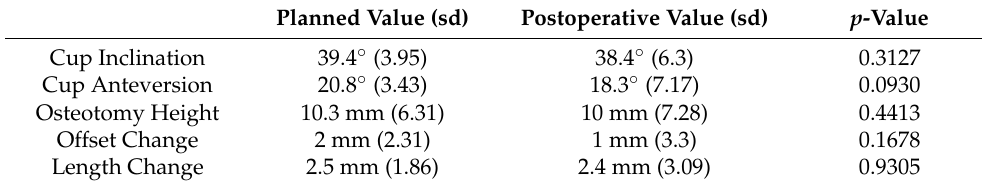
Table 1. Mean planned and postoperative values.